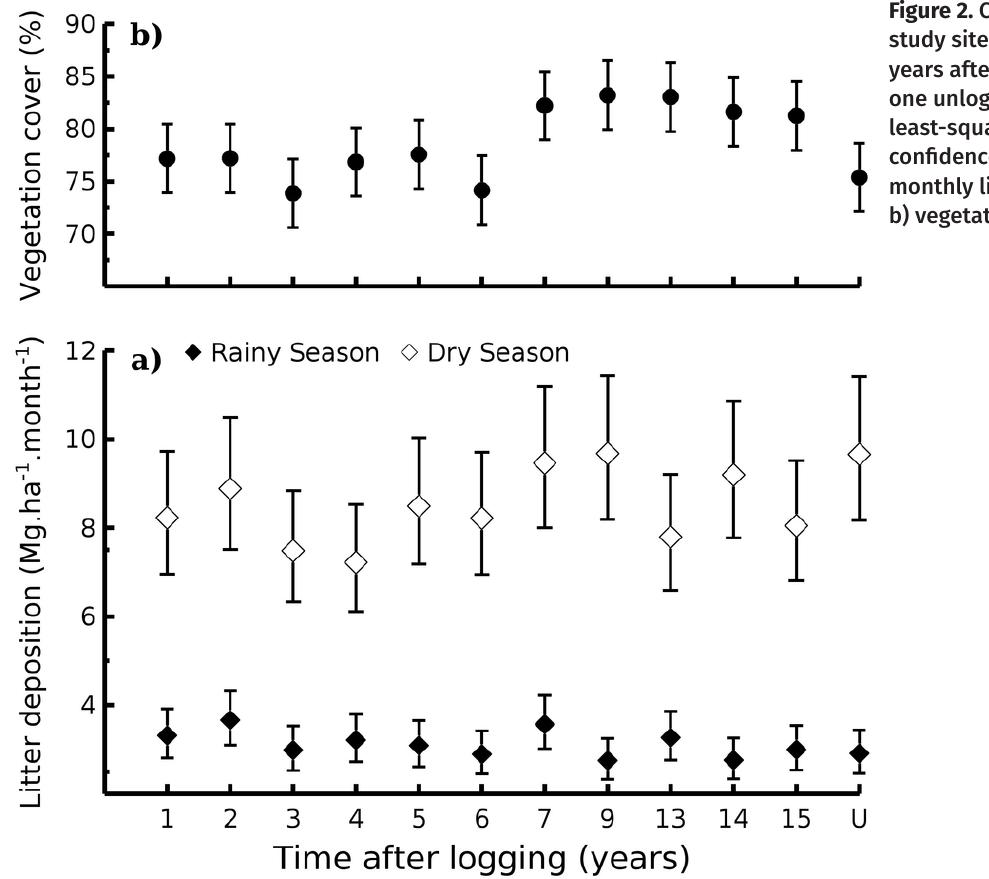
Figure 2. Comparisons of study sites with different years after logging and one unlogged site of the least-squares means and confidence intervals of: a) monthly litter deposition; b) vegetation